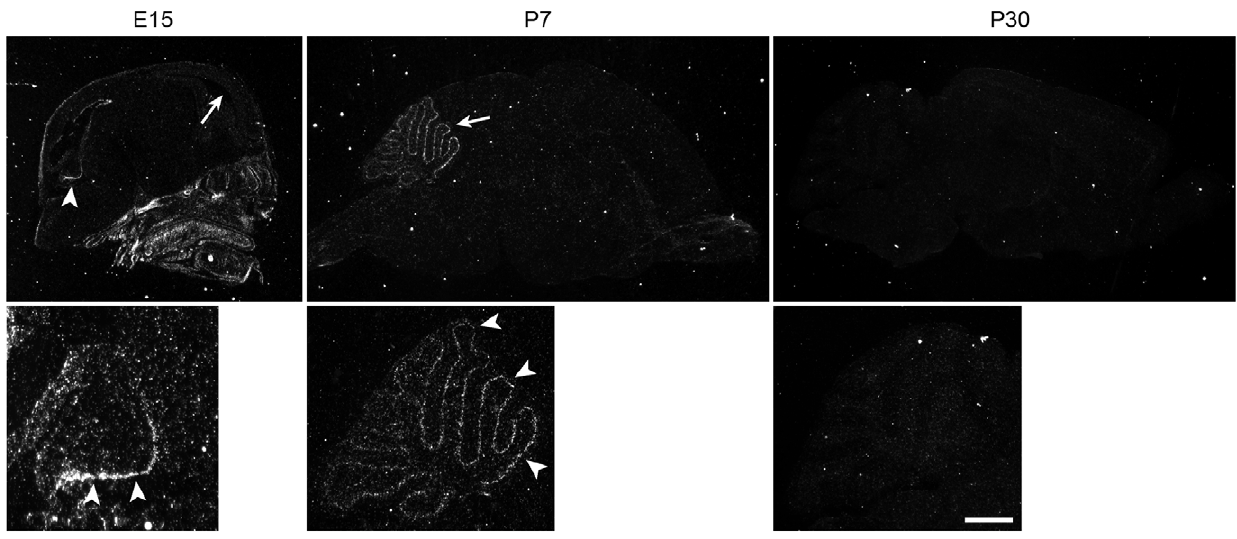
Figure 4. Identification of a developmentally regulated GPCR that is Bergmann glia-specific in the cerebellum. in situ hybridization with a 33 P-labeled probe for Gpr126 , a little known GPCR of the adhesion family, reveals signal specifically in the Purkinje cell layer at P7 (arrows, middle panels), consistent with expression in Bergmann glia. Gpr126 expression is developmentally regulated, and becomes undetectable in the adult (right panel). Unlike most classic Bergmann glial markers, which are also expressed by cortical radial glia, Gpr126 is specific to Bergmann glia and not detected in cortical radial glia at E15 (arrow in top left panel). Labeling is seen in the ventricular zone of the developing cerebellar anlage at E15 (arrowheads in left panels), suggesting that Gpr126 may be expressed in progenitors of Bergmann glia. All sections are oriented with rostral to the right. Scale bar, upper panels: left, 3 mm; center, 2 mm; right, 2.5 mm; lower panels: left, 100 m m; center, 1 mm; right, 1.4 mm.